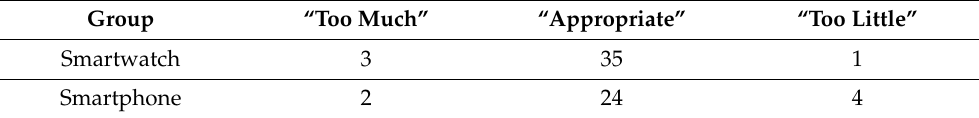
Table 2. Distribution of answers regarding the appropriateness of the number of notifications.